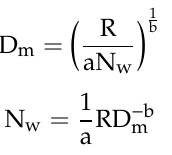
Figure 4. Scatter plots of the estimates in R ( left ), D m ( middle ) and N w ( right ) and their respective true values. Correlations between the estimates and truth and rms errors of the estimates, denoted by ‘corr’ and ‘rmse’, respectively, are also given.